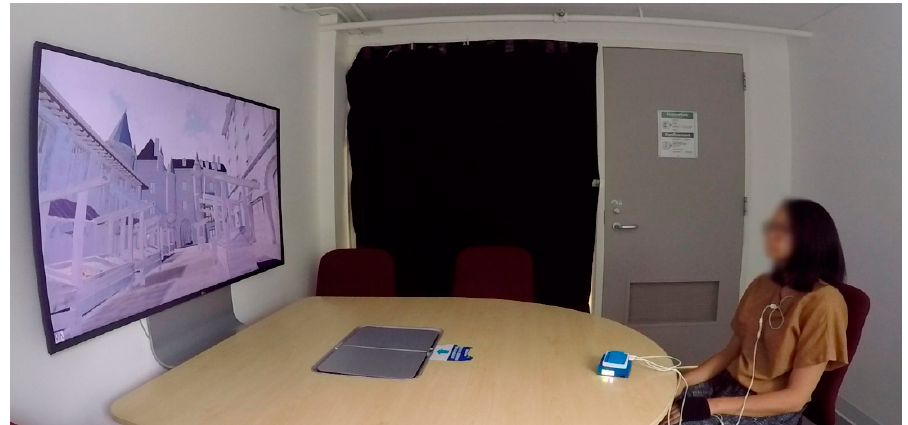
Figure 5. The flat screen viewing in the individual and low-immersion setting (Ind_Cont).